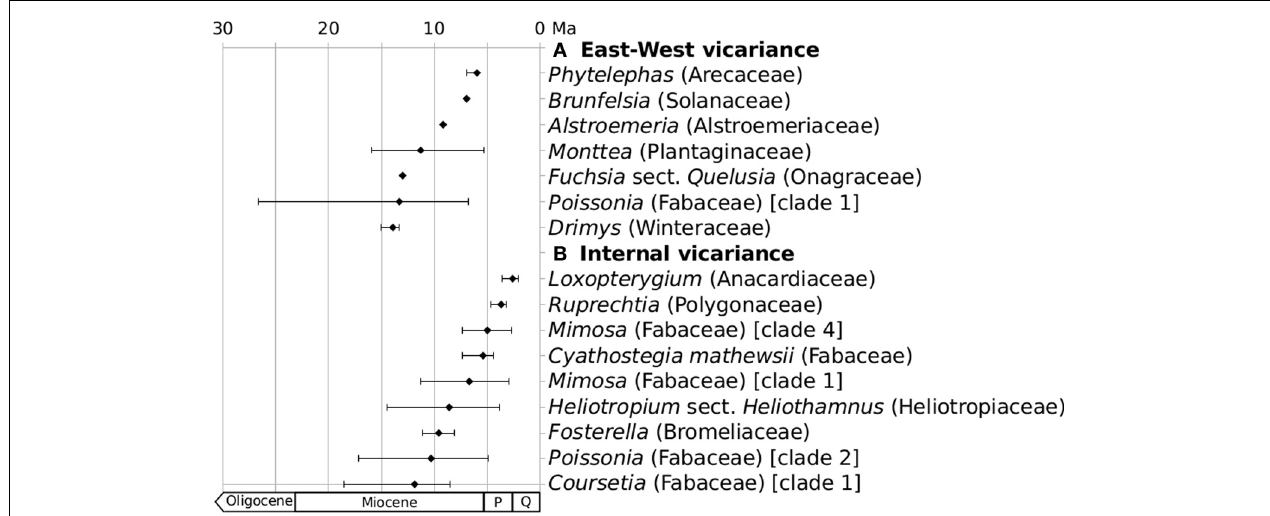
FIGURE 3 | Divergence times for plant groupsthatmay have diversified in responsetotheAndeanuplift.(A) Groupsdisjunctonthewesternandeastern sideoftheAndes; (B) GroupsdistributedintheinnerAndeanvalleys.Errorbars